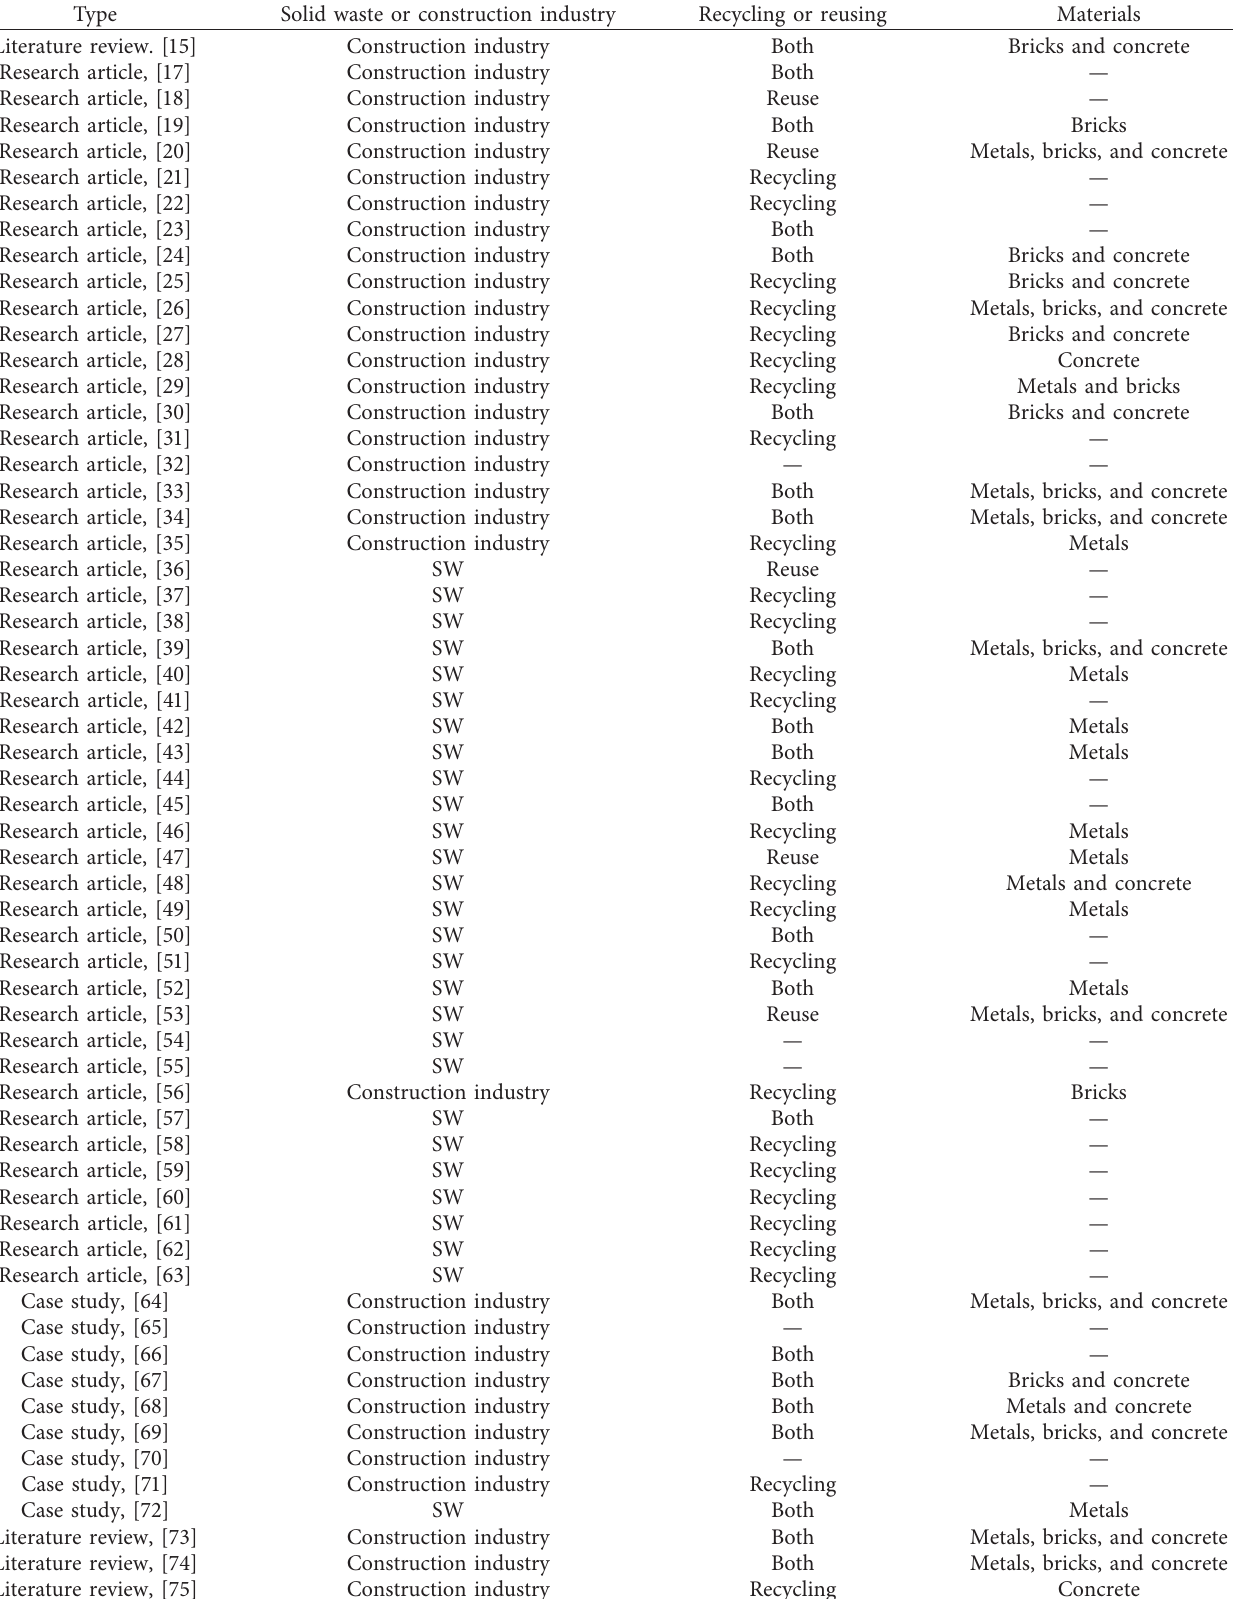
Table 1: Summary of the content of the publications selected for the bibliographic